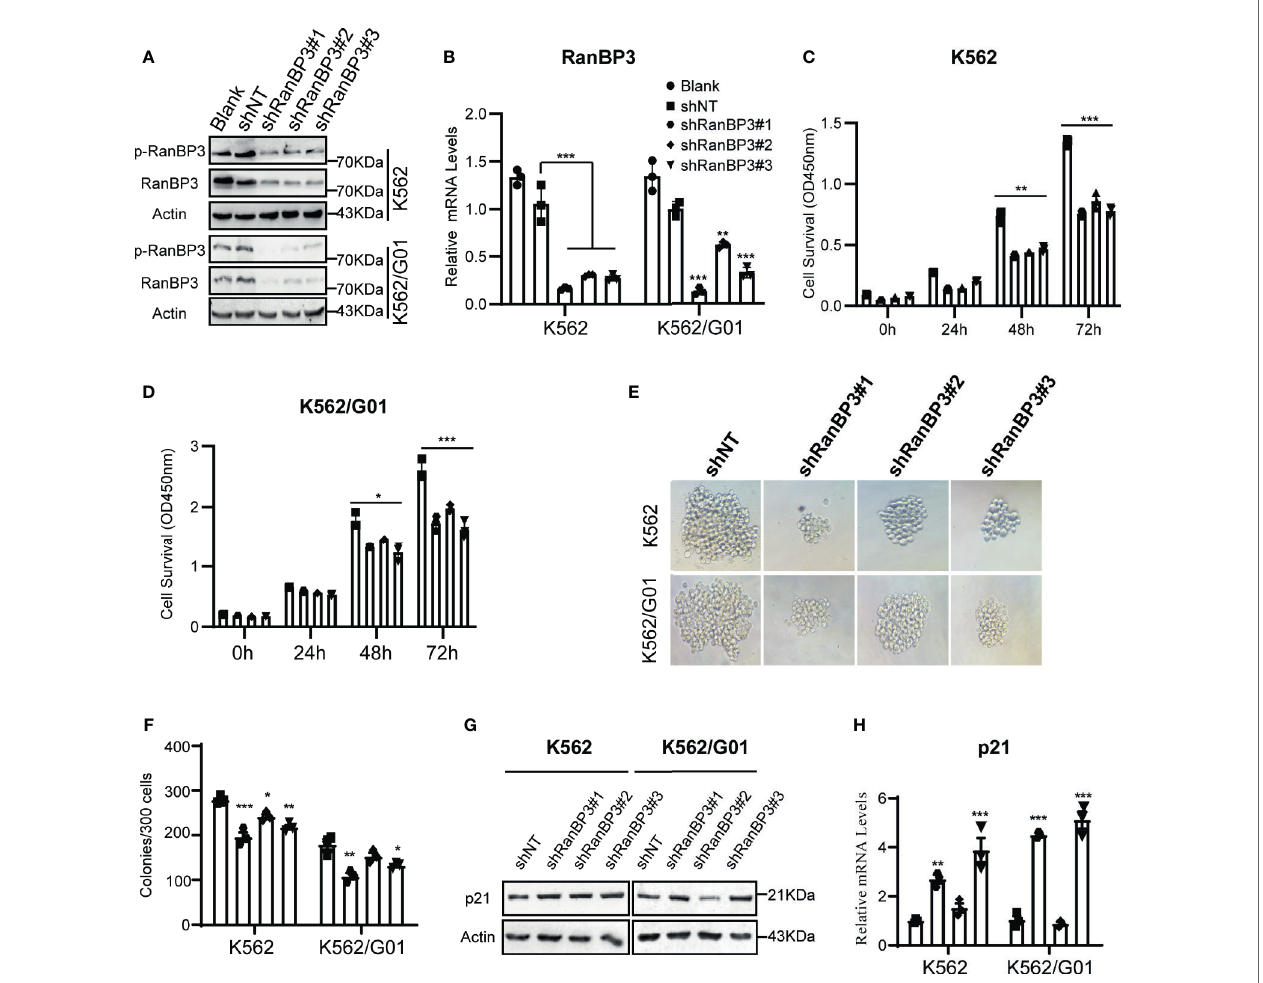
FIGURE 2 | Effect of RanBP3 on the proliferation of CML cells. K562 and K562/G01 cells were infected with the lentivirus-carrying shRanBP3 and control shRNAs for 72h and collected for following assays. (A, B) RanBP3 levels in shRanBP3 and control cells were measured by western blots and qRT-PCR. (C, D) Cell viability was detected by CCK-8 at indicated time-points. The size (E) and number (F) of colonies were measured in lentivirus infected K562 or K562/G01. The protein (G) and mRNA (H) levels of p21 were evaluated. *P < 0.05, **P < 0.01, ***P <